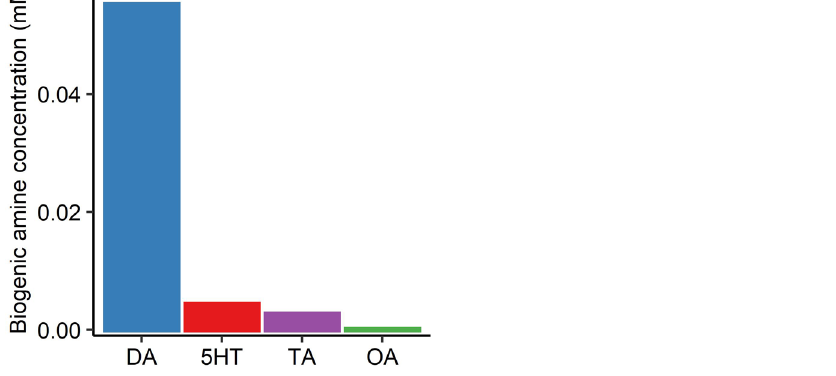
Figure 1. Concentrations of 4 biogenic amines in the ant-collected honeydew of M. yomogicola (total volume of honeydew = 6.56 µl, 0.111 ± 0.0118 µl (mean ± S.E.) per ant, n = 59). The concentrations of dopamine (DA), serotonin (5HT), tyramine (TA), and octopamine (OA) were 5.52 × 10 −2 , 4.36 × 10 −3 , 2.70 × 10 −3 , and 1.09 × 10 −4 mM,